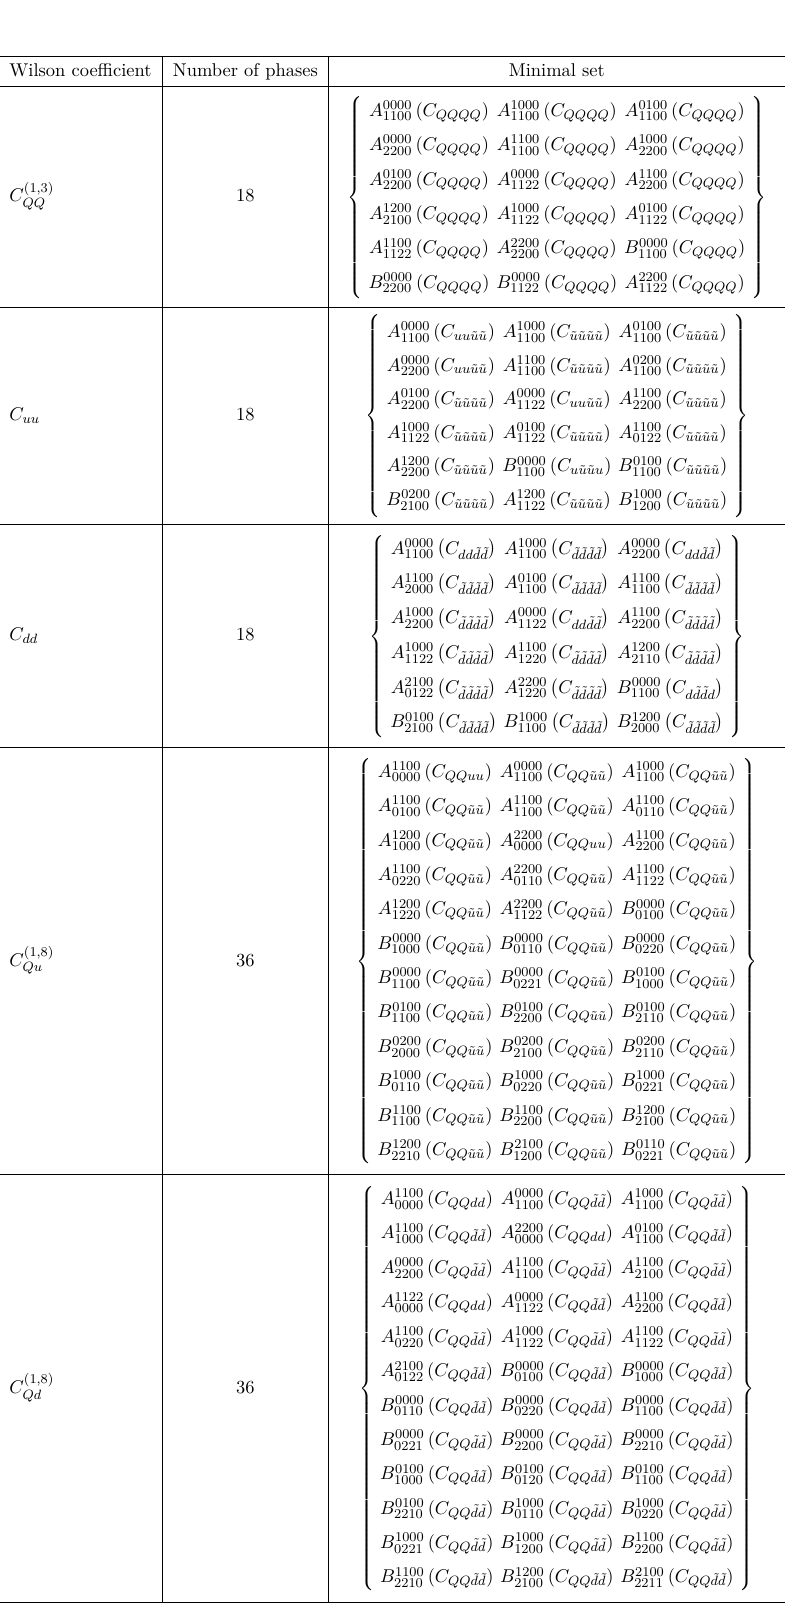
Table 12 . Continuation of table